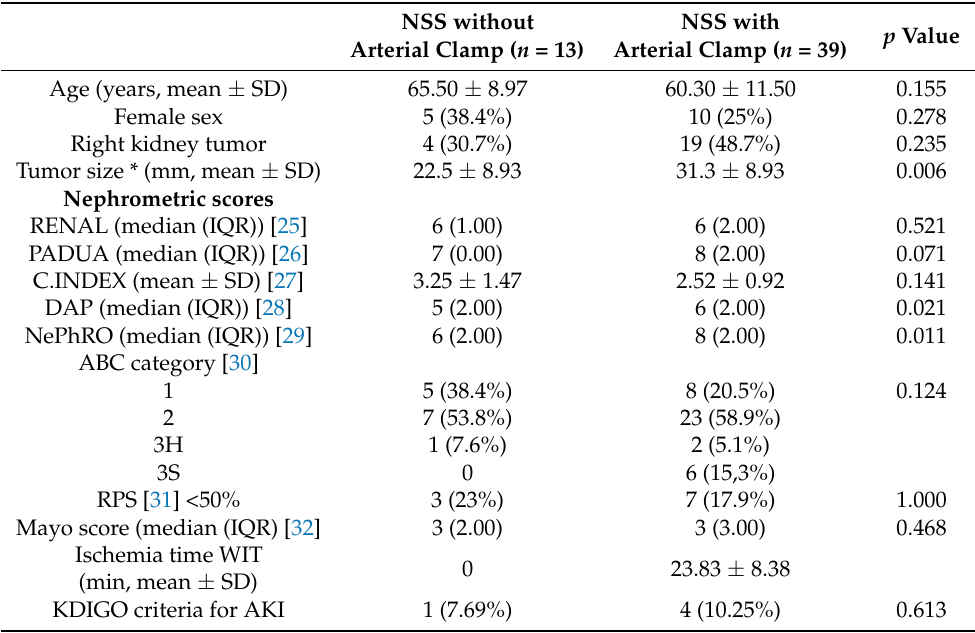
Table 1. Characteristics of NSS patients without and with arterial clamping.